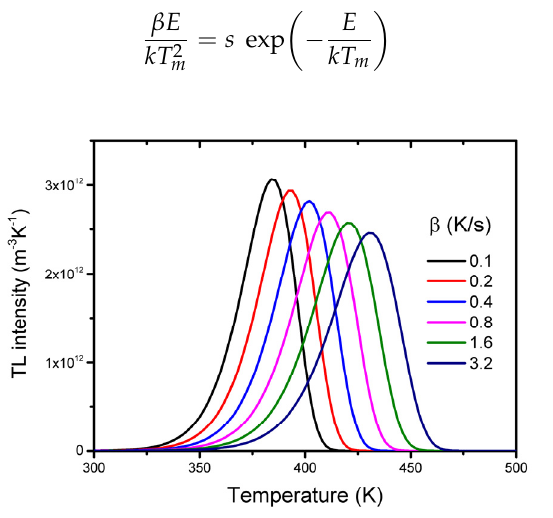
Figure 3. TL glow peaks calculated with the Randall-Wilkins Equation (4) for n 0 = 10 14 m − 3 ; s = 10 11 s − 1 , E = 1 eV and different values of the heating rate β